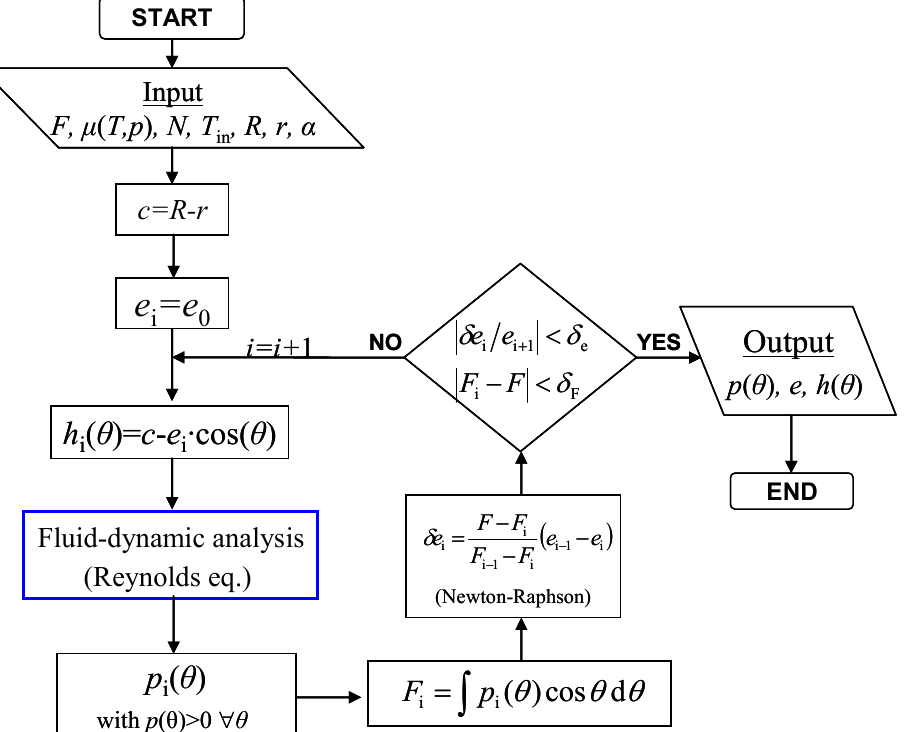
Figure 2: Sketch of the numerical algorithm for fluid-dynamic analysis of journal bearing (rigid